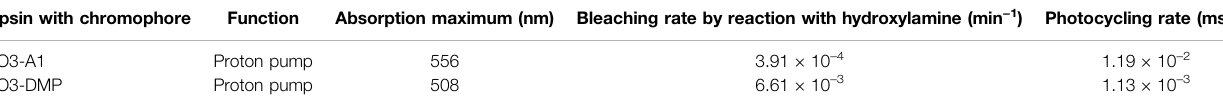
TABLE 1 | Functional and photochemical properties of AO3 with all- trans A1-retinal and DMP-retinal. Photocycling rates represent inverse numbers of τ 3 , the decay time constant of O intermediate, which is a rate limiting step of the photocycle.